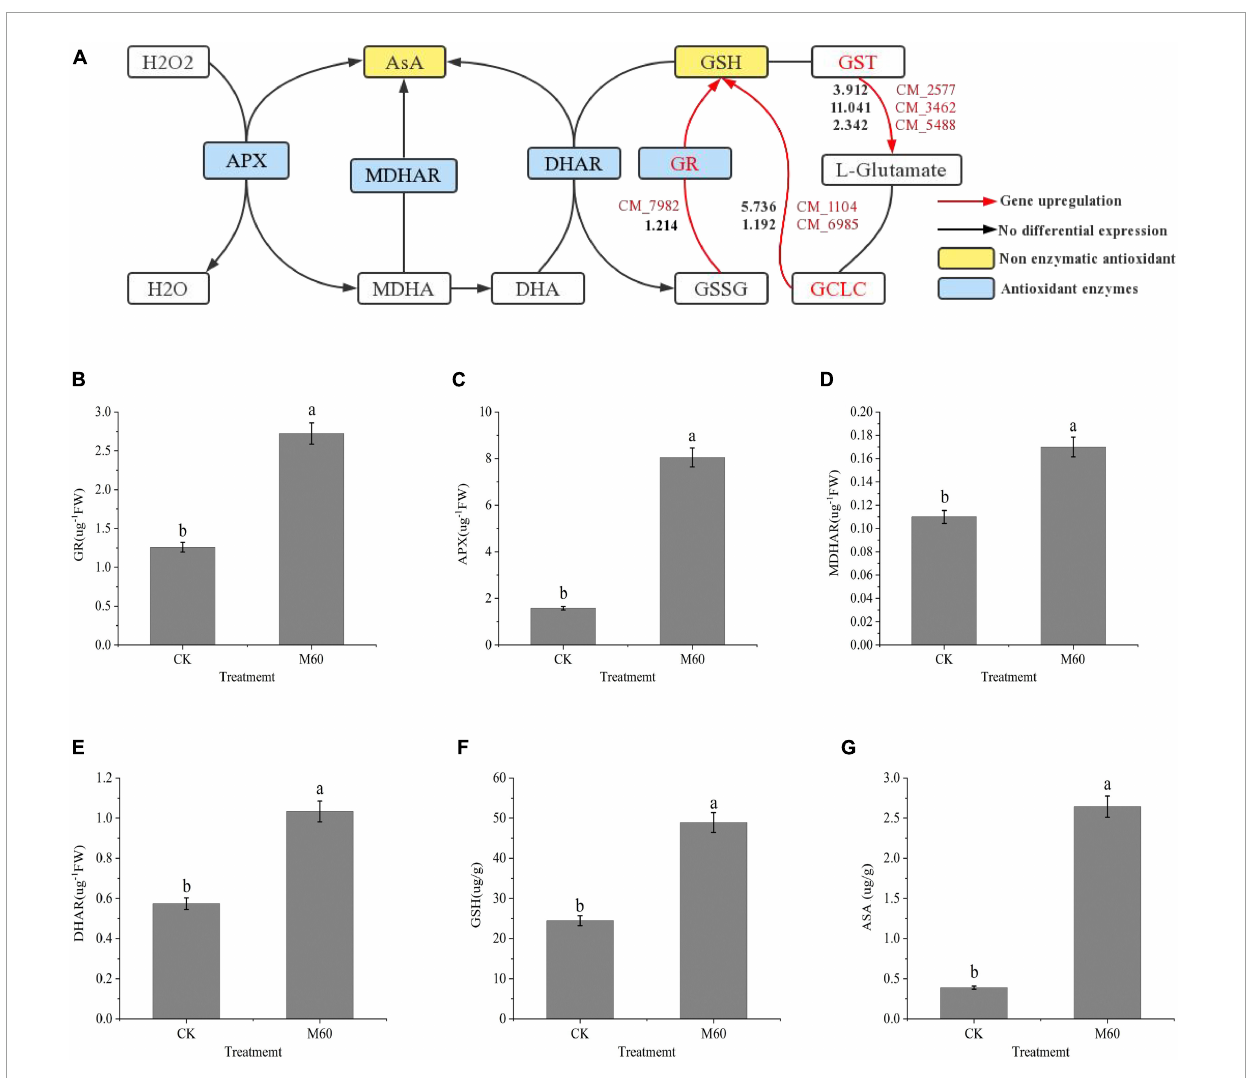
FIGURE6 ASA-GSH cycle alleviates oxidative stress in C. militaris strain CK vs. M60 after MT treatment. (A) ASA-GSH cycle and glutathione metabolic pathway. The red mark next to the red line represents the DEGs, and the black number represents the DEGs expression. (B) GR content of CK and M60. (C) APX content of CK and M60. (D) MDAHR content of CK and M60. (E) DHAR content of CK and M60. (F) ASA content of CK and M60. (G) GSH content of CK and M60. The different letters represent significant differences among treatments according to Duncan’s multiple range tests ( p < 0.05). Data are represented as means ± SD, n = 3. M60, add 60 µ mol L − 1 of MT. H 2 O 2 , hydrogen peroxide; ASA, ascorbic acid; GSH, glutathione; APX, ascorbic acid peroxidase; MDHAR, monodehydroascorbate reductase; DHAR, dehydroascorbic acid reductase; GR, glutathione reductase; MDHA, monodehydroascorbic acid; DHA, dehydroascorbic acid; GSSG, glutathione oxidized; GCLC, recombinant glutamate cysteine ligase; GST, glutathione